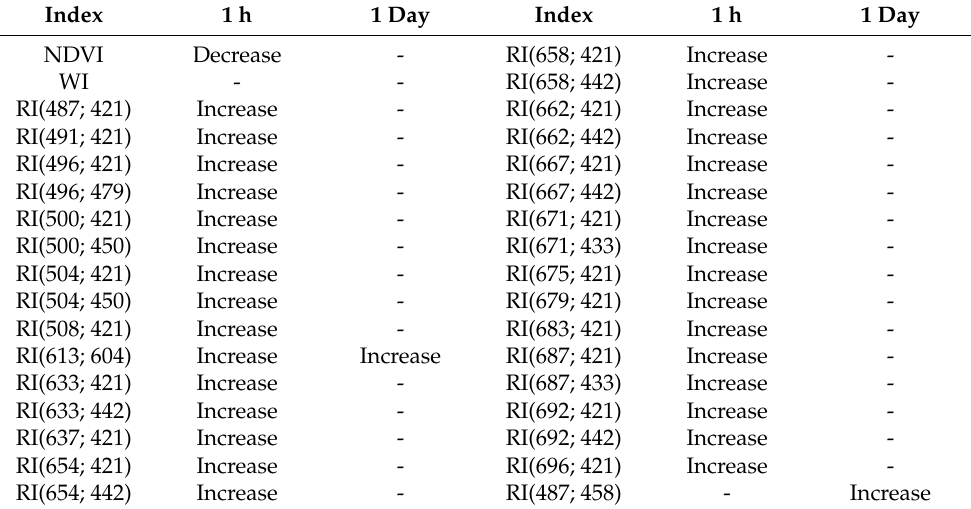
Table 3. Changes in absolute values of NDVI, WI, and the water shortage sensitive RIs (from Table 2) after the short-term